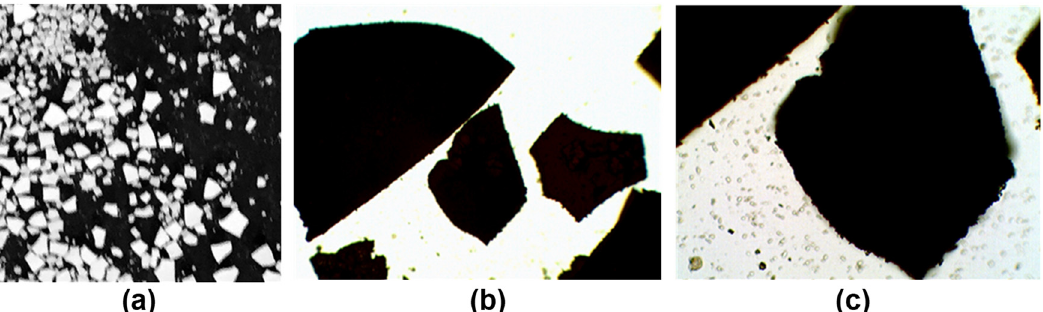
Figure 3: The powder of phosphor sample D after ball milling, washing, drying the water colloid in a Petri dish in the open air and scraping from the bottom of the Petri dish. No oleic acid was added to the colloid before drying. ( a ) The photograph of the scales of the dry powder taken with iPhone 6 camera; dimensions: 17 mm × 17 mm. ( b ) The microscope photograph of the scales taken with magni fi cation × 40; dimensions: X = 2,257 µm and Y = 1,674 µm. ( c ) The microscope photograph of the scales taken with magni fi cation × 100; dimensions: X = 903 µm and Y = 670